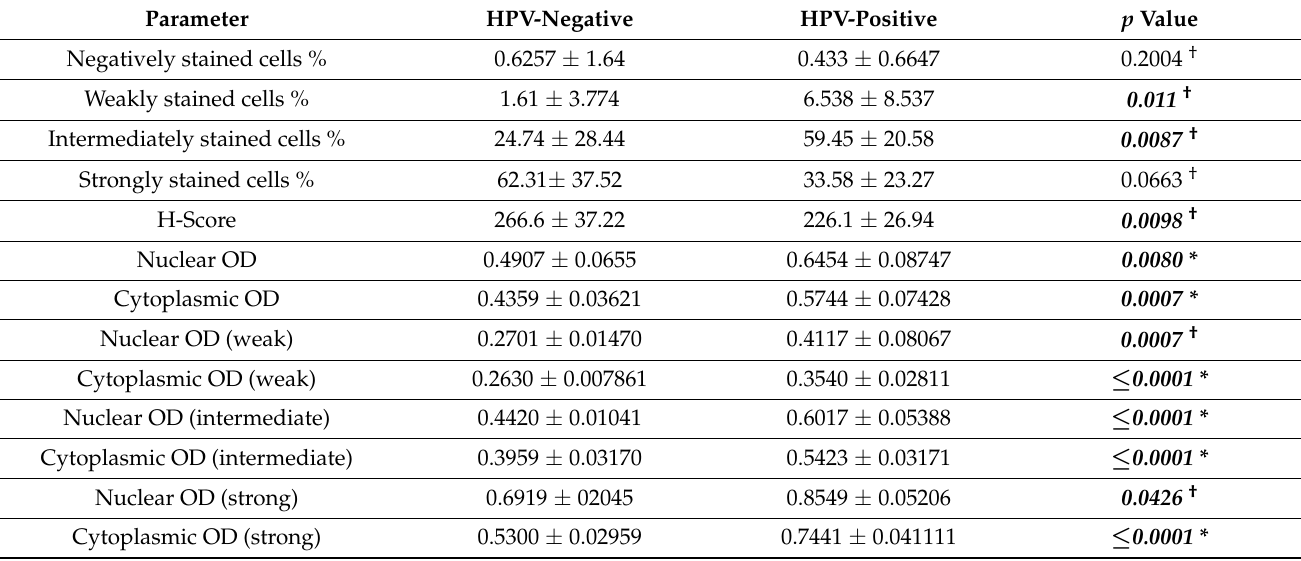
Table 1. Comparison of staining intensity and H-score between HPV-positive and HPV-negative oropharyngeal